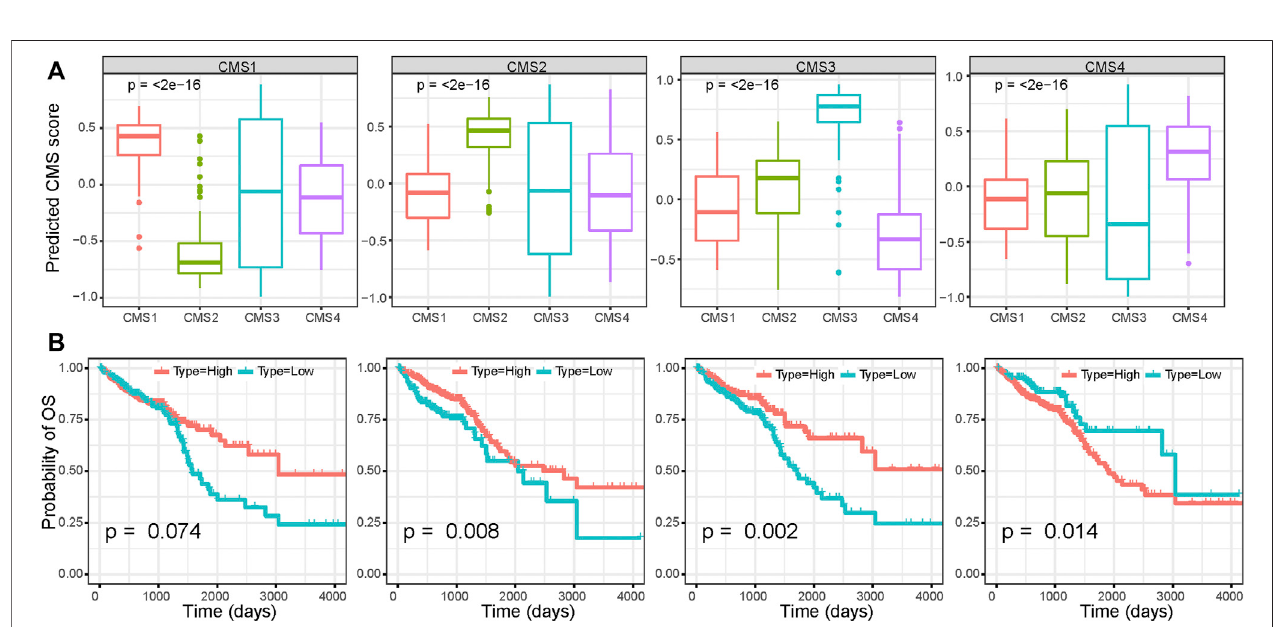
FIGURE 5 | Survival analysis based on the CMS index (A) CMS index of each CMS subgroup (B) Survival analysis of CRC patients based on the CMS index.